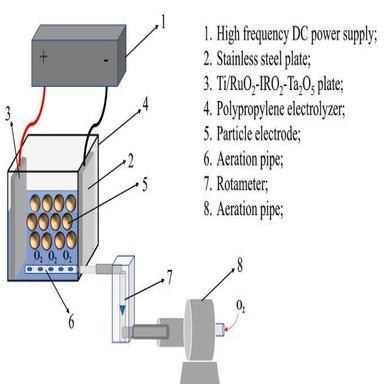
The experimental device.